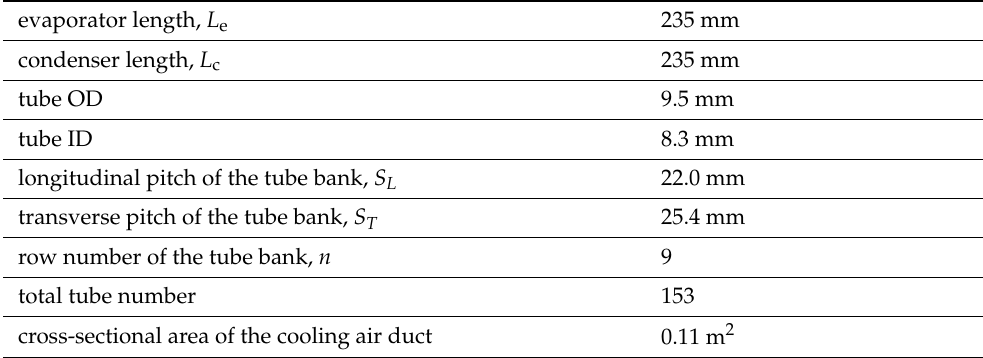
Table 3. Geometric parameters of the